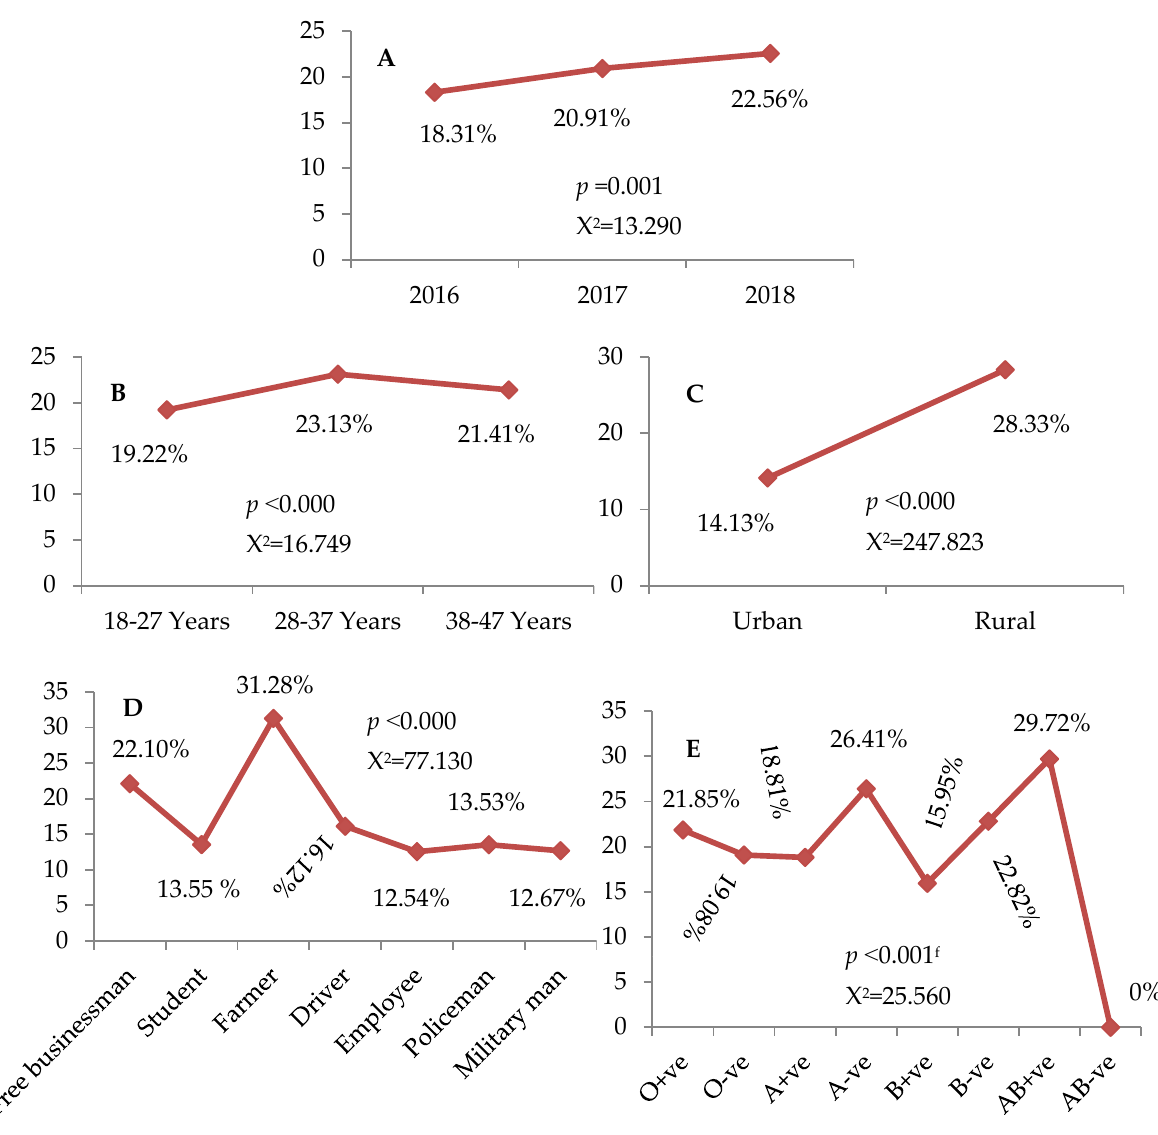
Figure 1. ( A – E ): Trend of the single serologic marker. ( A ): Throughout 2016 to 2018, ( B ): among age groups, ( C ): according to the residence, ( D ): in relation to occupations, ( E ): among blood groups and Rhesus factor. X 2 : chi-squared. Data assessed by the Pearson chi-squared and Fisher’s exact tests f .